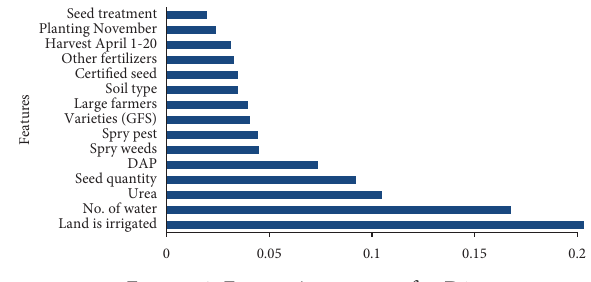
Figure 4: Feature importance for D1.